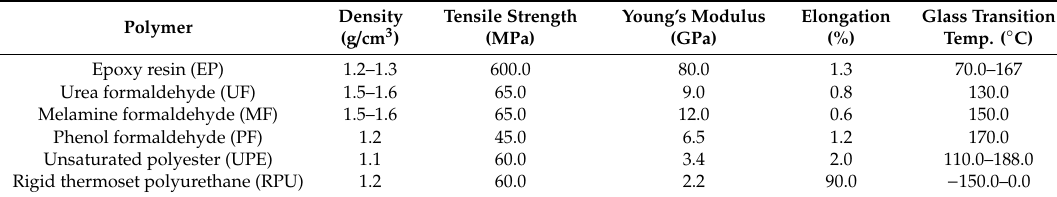
Table 11. Mechanical properties of thermoset